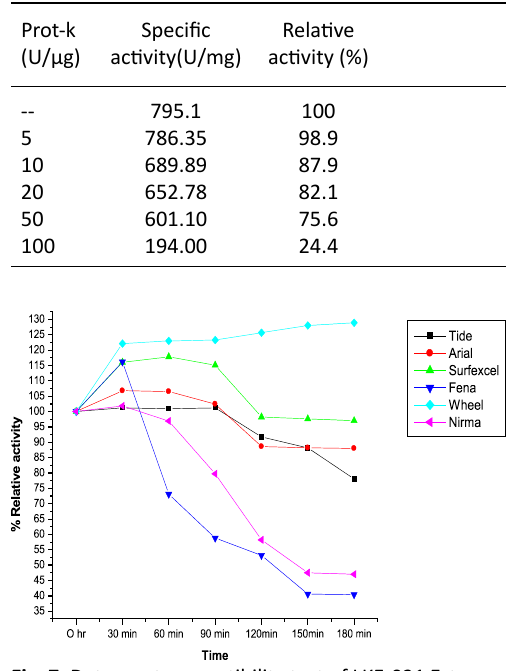
Fig. 6. Organic solvent'seffects on the stability of LKE- 021 esterase.